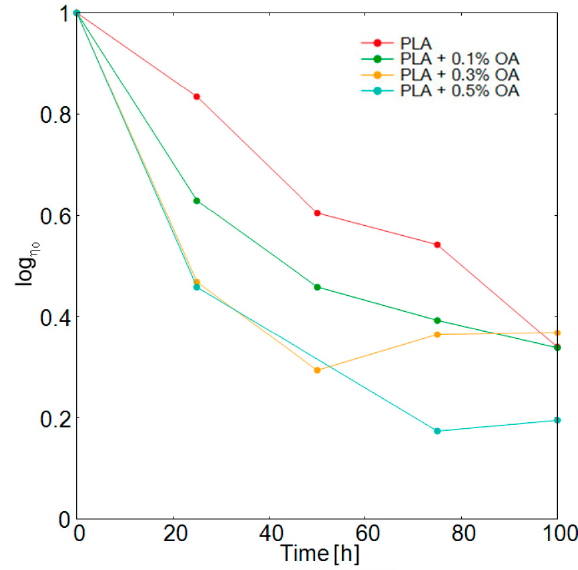
Figure 6. Dependence of the zero shear viscosity of PLA materials with different contents of OA on the period of photodegradation.